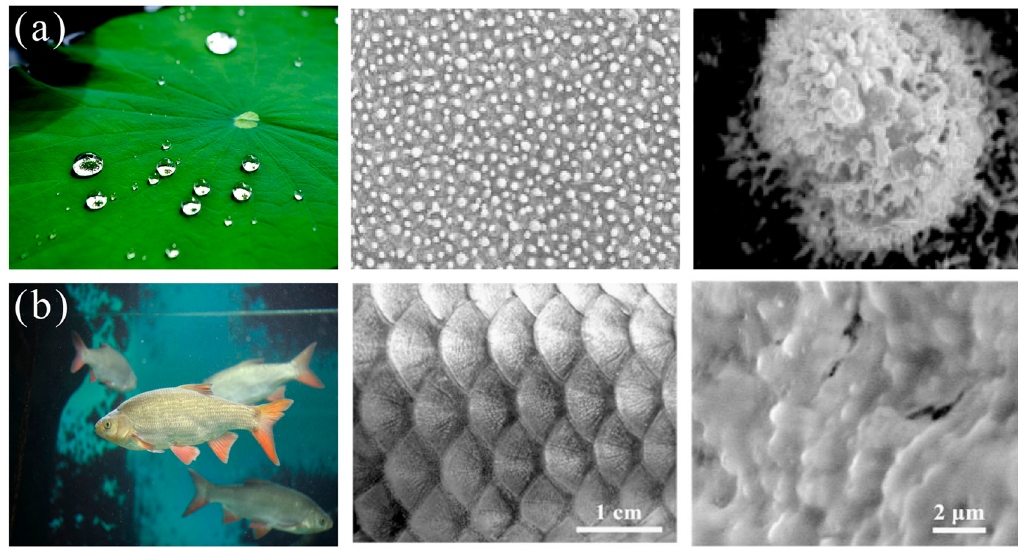
Figure 2. Biological surfaces with super-wettability and their structures: ( a ) lotus leaf [29]; reproduced with permission from Wiley. ( b ) fish scales [30]; reproduced with permission from Wiley.